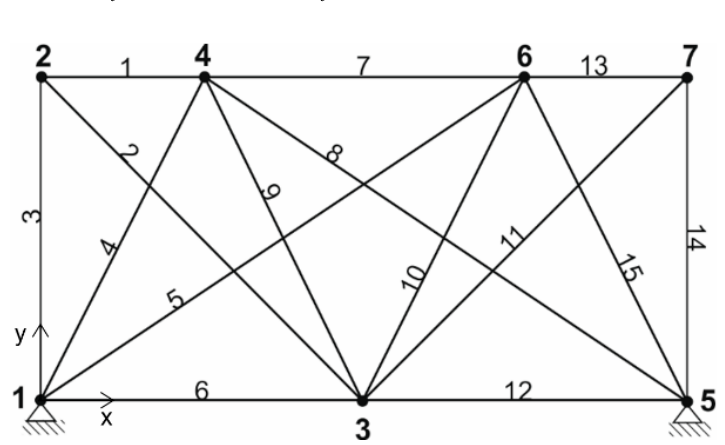
Figure 10. 15 bar structure—initial configuration. Superscript denotes the node number where the force acts. Other parameters needed for the solution are E = 2.1 × 10 5 MPa, N 0 = 80,000,000, c = 1, e = 10, a = 0.51, b k = 0 for k = 1, . . . , 7. Seven bits were used for parameterization of one variable, and the maximum bar cross-section could be 63.5 cm 2 . The population consisted of 30 individuals. The maximum allowed stress was 50